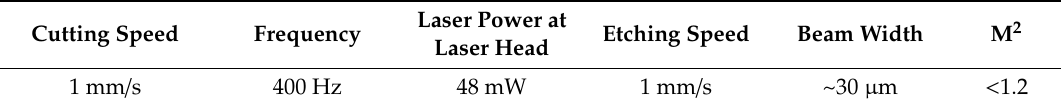
Table 3. Laser texturing process parameters.